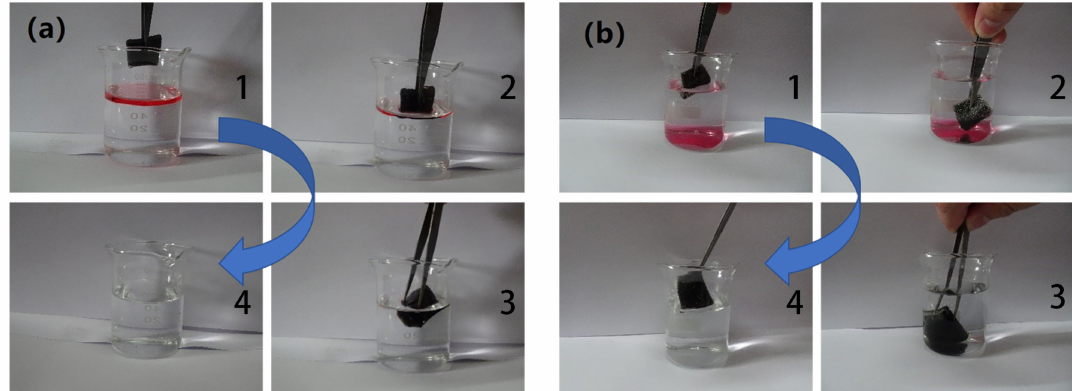
Figure 8. ( a ) Optical images of the removal process of hexadecane from the water surface using OTS-CNTs/PU sponge; ( b ) optical images of the removal process of chloroform from underwater using OTS-CNTs/PU sponge (The blue arrow shows the sequence 1–4 of oil absorption process).